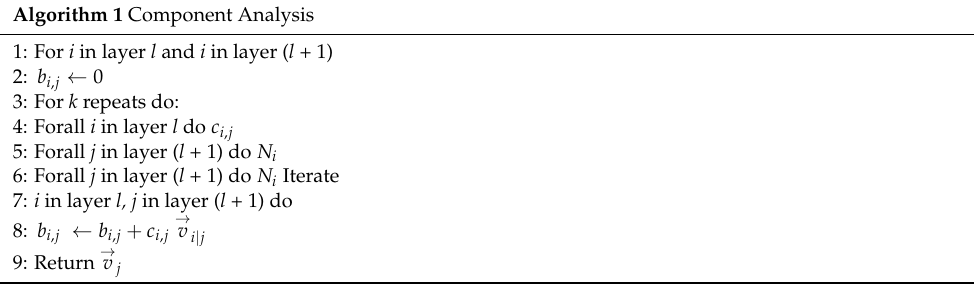
Algorithm 1 Component